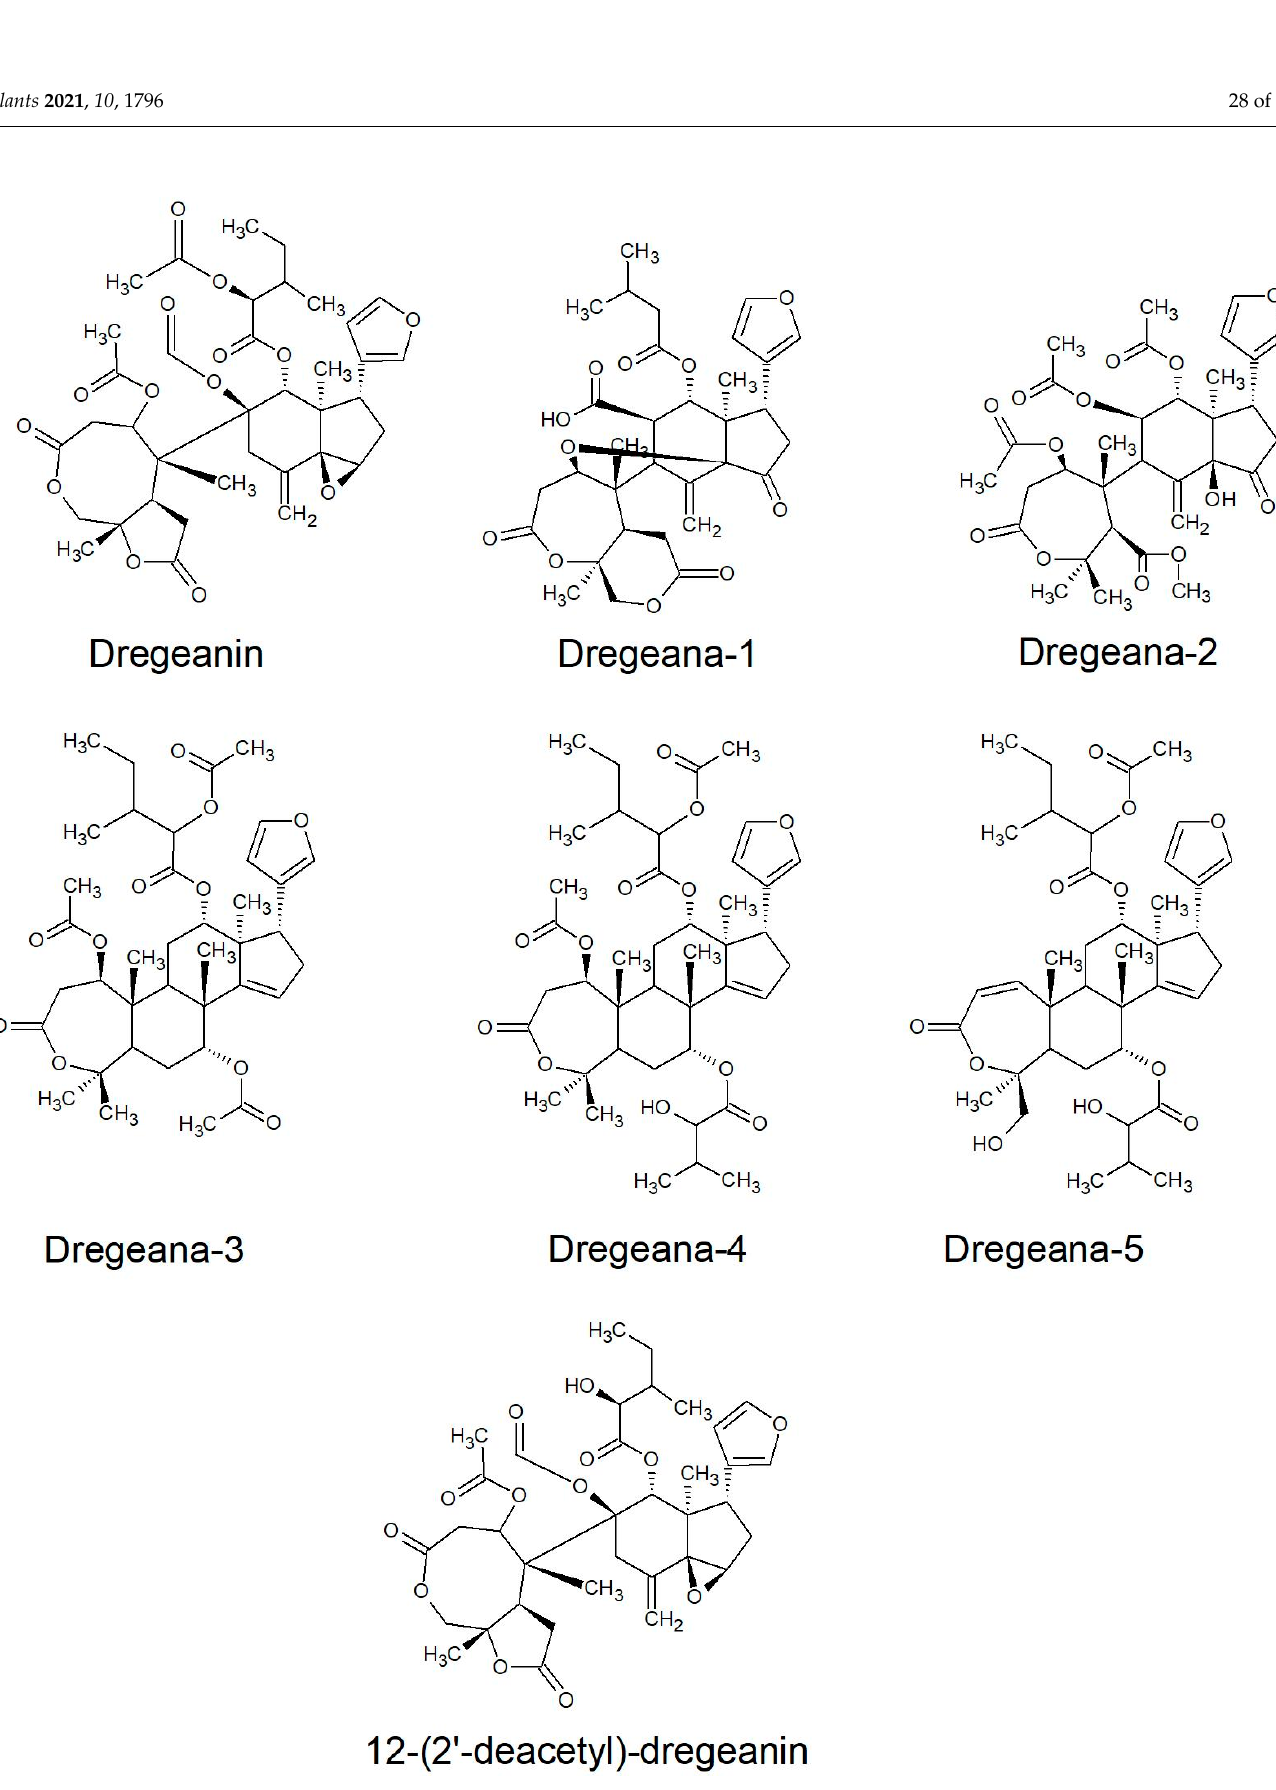
Figure 8. Dregeanin series of limonoids reported from South African Meliaceae [117,136] .